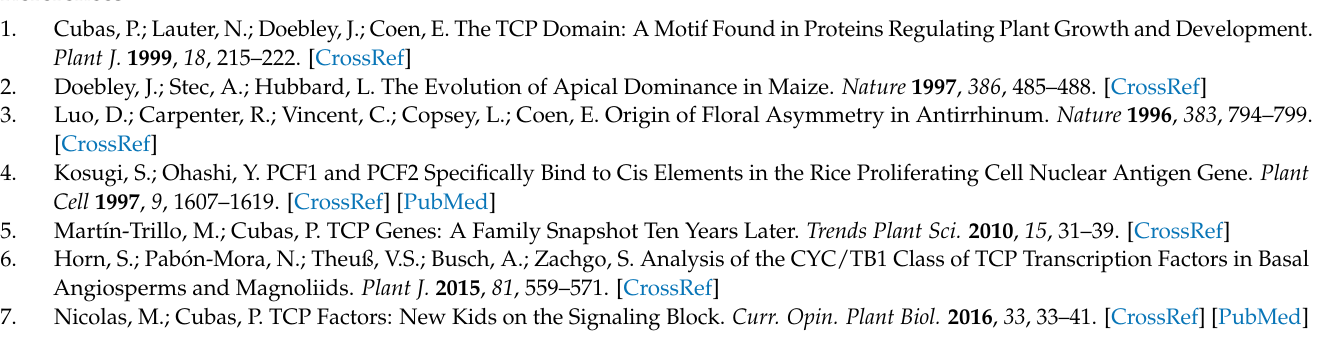
genes in different tissues. Table S2: Expression (FPKM) of DgTCP genes in different floral bud development stages. Table S3: Expression (FPKM) of DgTCP genes in different development tissues of high- and low-tillering orchardgrass. Table S4: The name and sequence information of primers involved in this study. Table S5: List of the 22 DgTCP genes identified in this study. Table S6: Analysis of conserved motifs of TCP protein in orchardgrass. Table S7: Segmental duplication analysis of TCP genes in orchardgrass genome. Table S8: One-to-one orthologous relationships between orchardgrass and other plants. Table S9: Cis-acting elements of 22 TCP genes in Dactylis glomerata